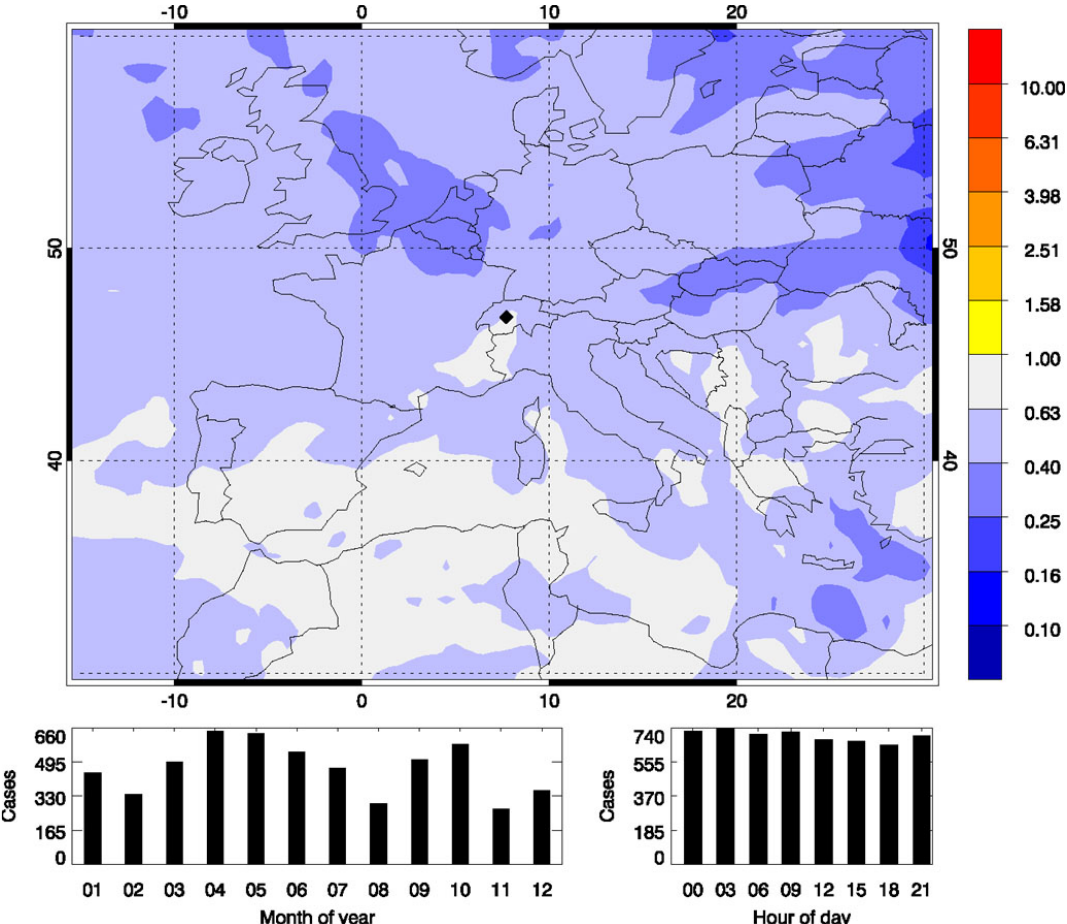
Fig. 10. Relative footprint map of trajectories associated with background values of CO 2 and O 2 recorded at Jungfraujoch (background calculated as explained in Sect. 3.1) See Fig. 7 for explanation of the color legend. The lower panels show the number of trajectories that were released in a specific month (left) and in a specific period of the day